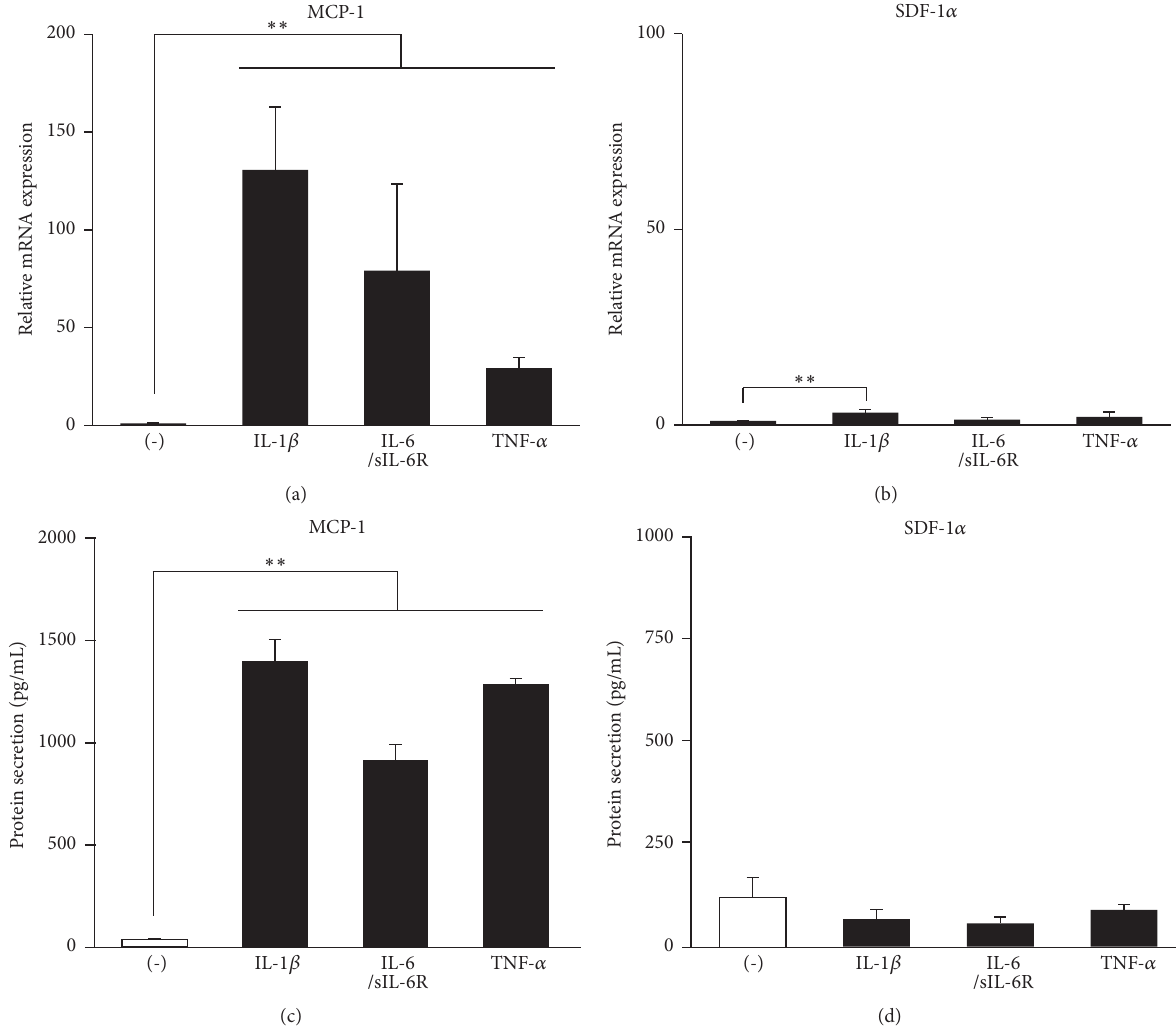
Figure 1: Inflammatory cytokines promote MCP-1 production in SCDC2 cells. SCDC2 cells were stimulated with or without 10ng/mL of IL-1 𝛽 , IL-6/sIL-6R, or TNF- 𝛼 . (a, b) mRNA expression levels were investigated by RT-qPCR using rat-specific primers. Reported values are normalized to Gapdh expression. The results are expressed as the fold change relative to the respective control (-). (c, d) The amount of secreted chemokines was measured using sandwich ELISA kits for rat-specific MCP-1 and SDF-1 𝛼 . Data are presented as the mean ± standard deviation. ∗ 𝑃 < 0.05 and ∗∗ 𝑃 < 0.01 as compared with the unstimulated control